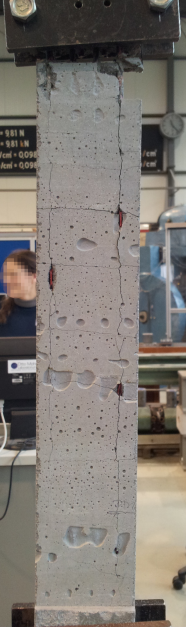
Figure 13. Experimental setup of TRC tensile test specimens according to [36], (photo by H. Michler (Institute of Concrete Structures, TU